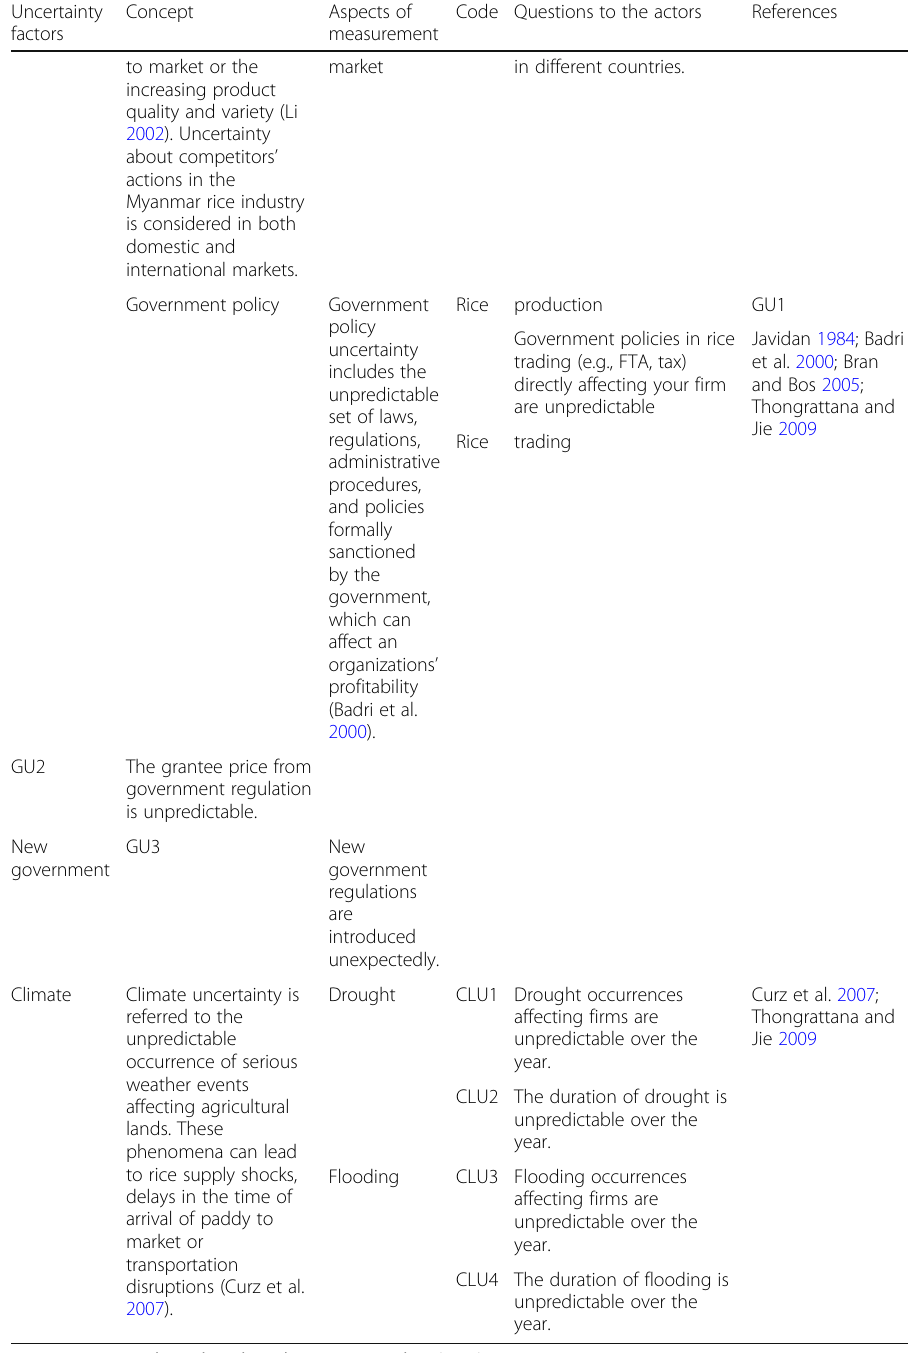
Table 3 Questionnaire items of uncertainty factors (Continued) Uncertainty factors